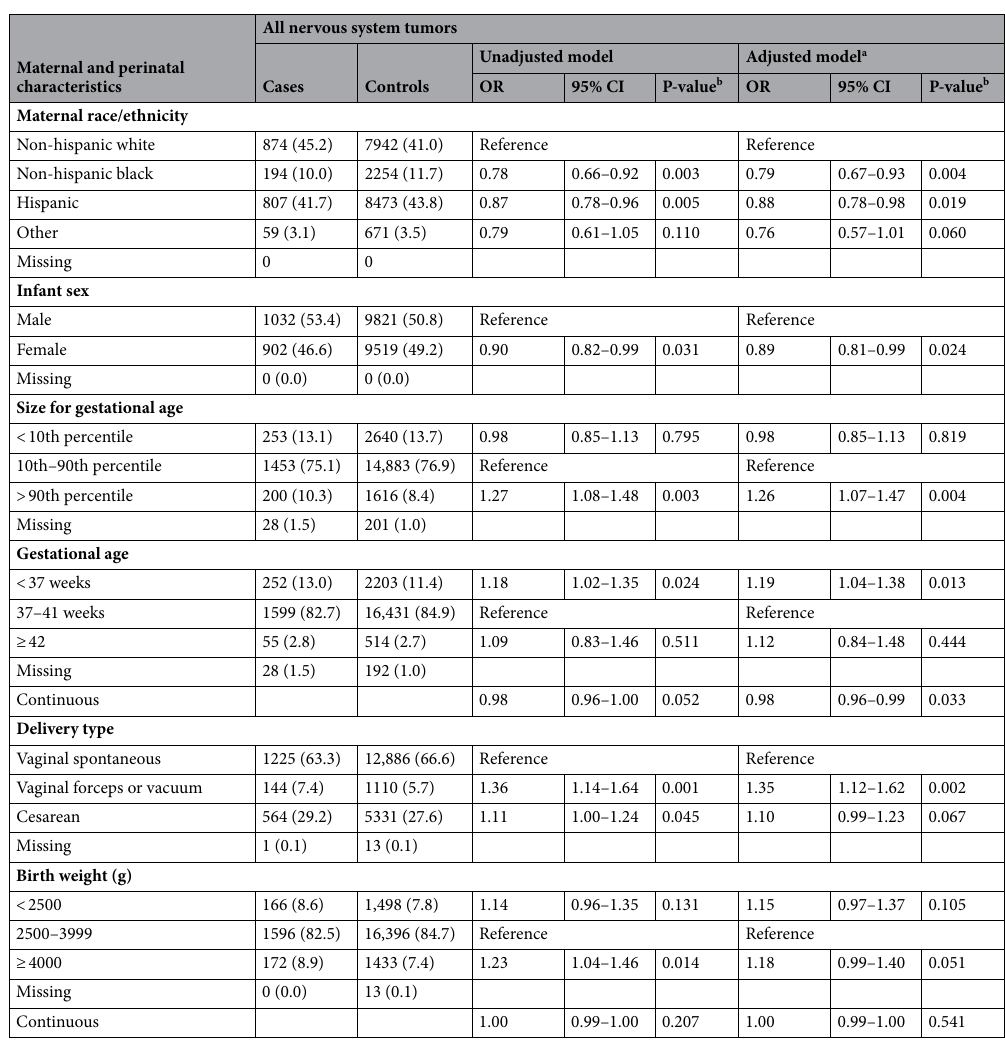
Table 2. Significant associations between maternal and perinatal factors and risk of pediatric central nervous system tumors. a Adjusted for birth year, sex, maternal race/ethnicity, and maternal education. b Bonferroni corrected reference P values: 0.003 for an experiment-wide significance of